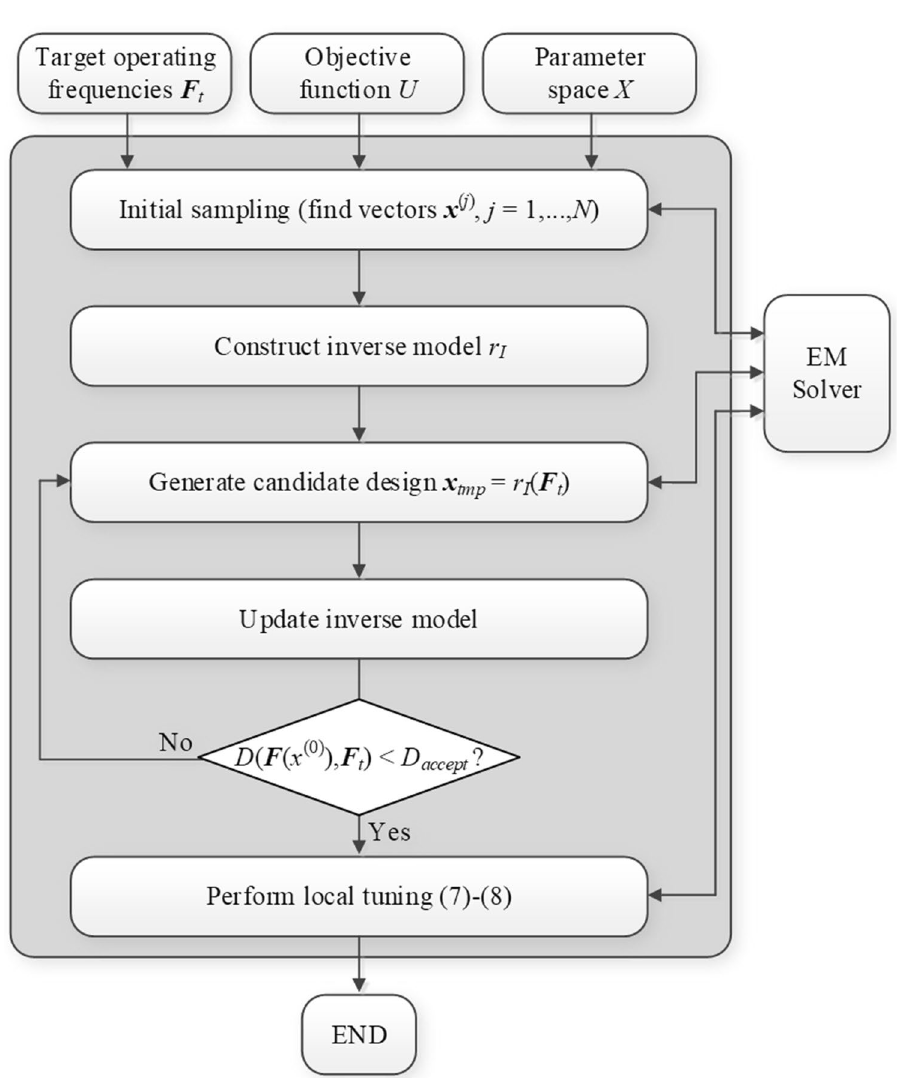
Figure 5. Flow diagram of the proposed framework for globalized optimization of microwave components.